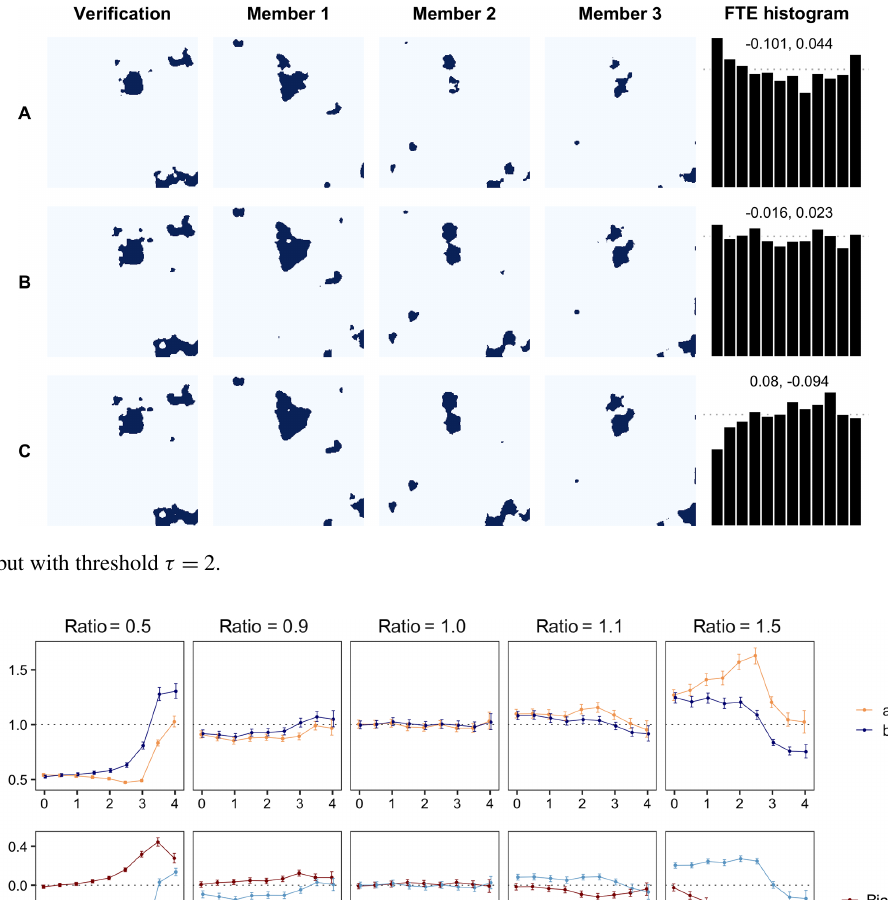
Figure 5. Estimated beta distribution parameters (top) and corresponding β -score and β -bias (bottom) of FTE histograms calculated over different thresholds for forecasts with low, even, and high correlation length ratios about a 0 = 2. Vertical lines denote the 95% confidence interval found via the nonparametric bootstrap